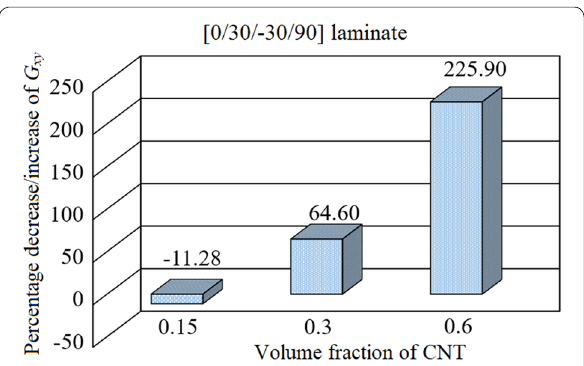
Fig. 9 Percentage increase/decrease in G xy of CNT/epoxy with volume fraction as compared to CF/epoxy at a constant 60% CF volume fraction for [0/30/–30/90] stacking sequence of